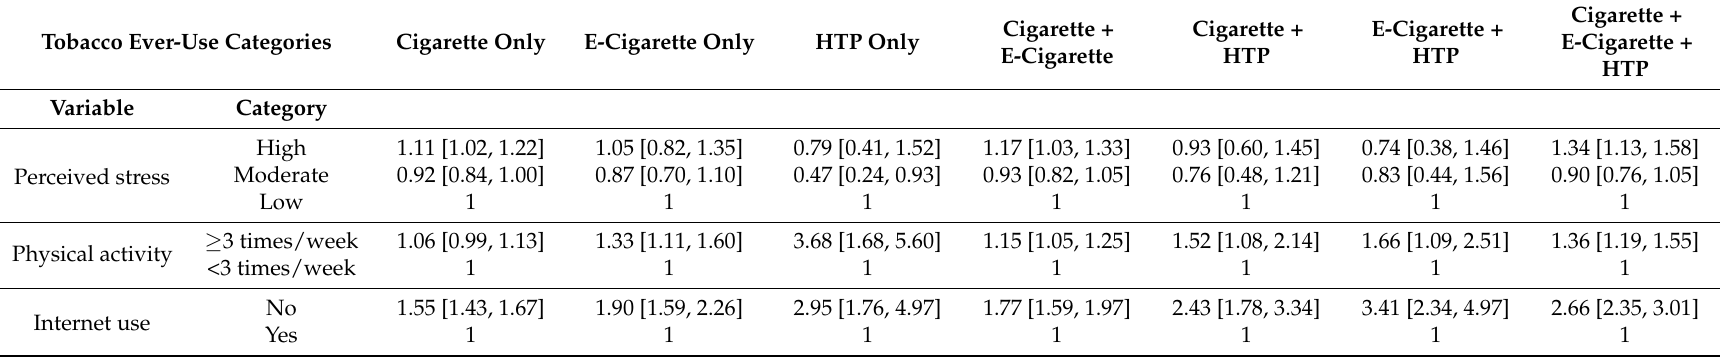
Table 3. Multinomial logistic regression examining perceived stress, physical activity, and internet use by tobacco ever-use patterns. Tobacco Ever-Use